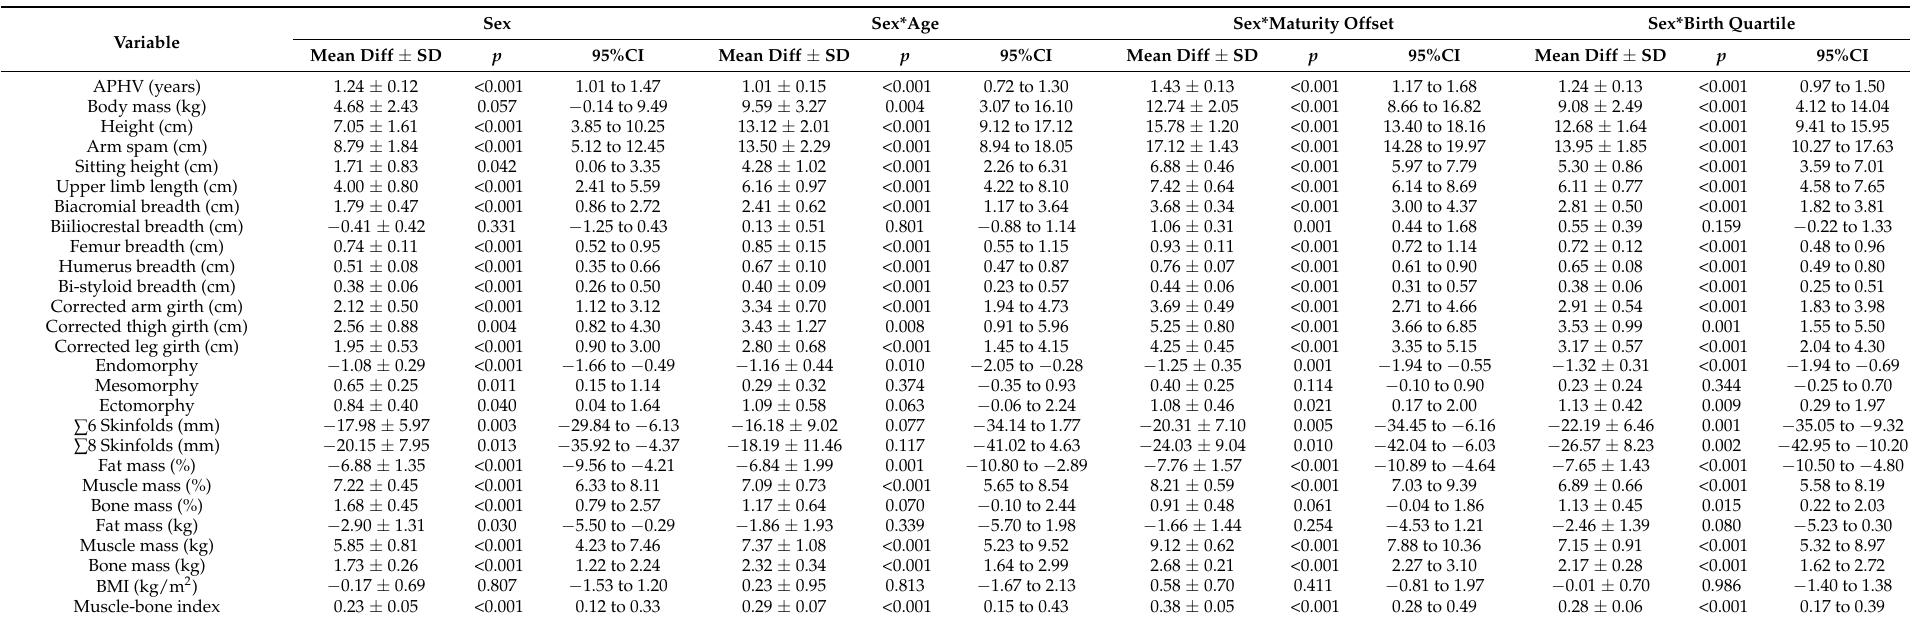
Table 3. Post hoc Bonferroni adjustment for the different covariates for the APHV and kinanthropometric